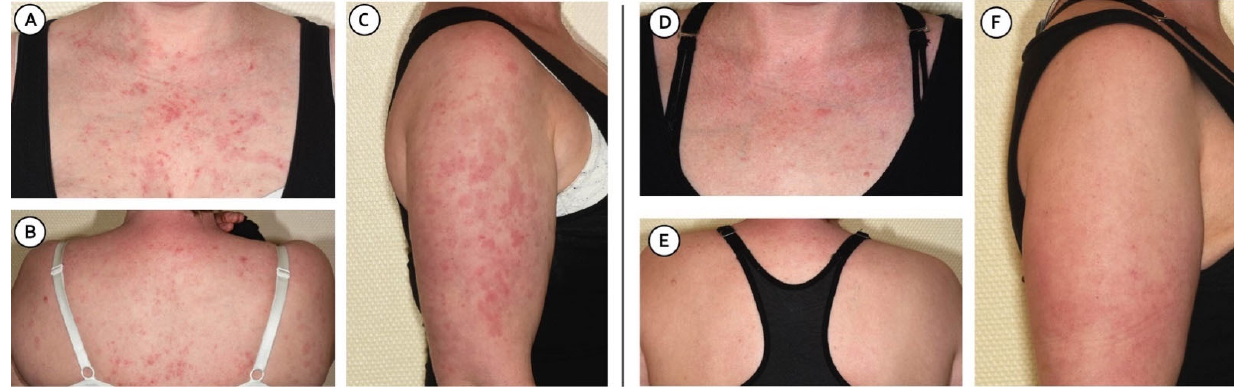
Figure 1. Cutaneous manifestations of the patient before ( A – C ) and eight weeks after the initiation of anifrolumab treatment ( D – F ).